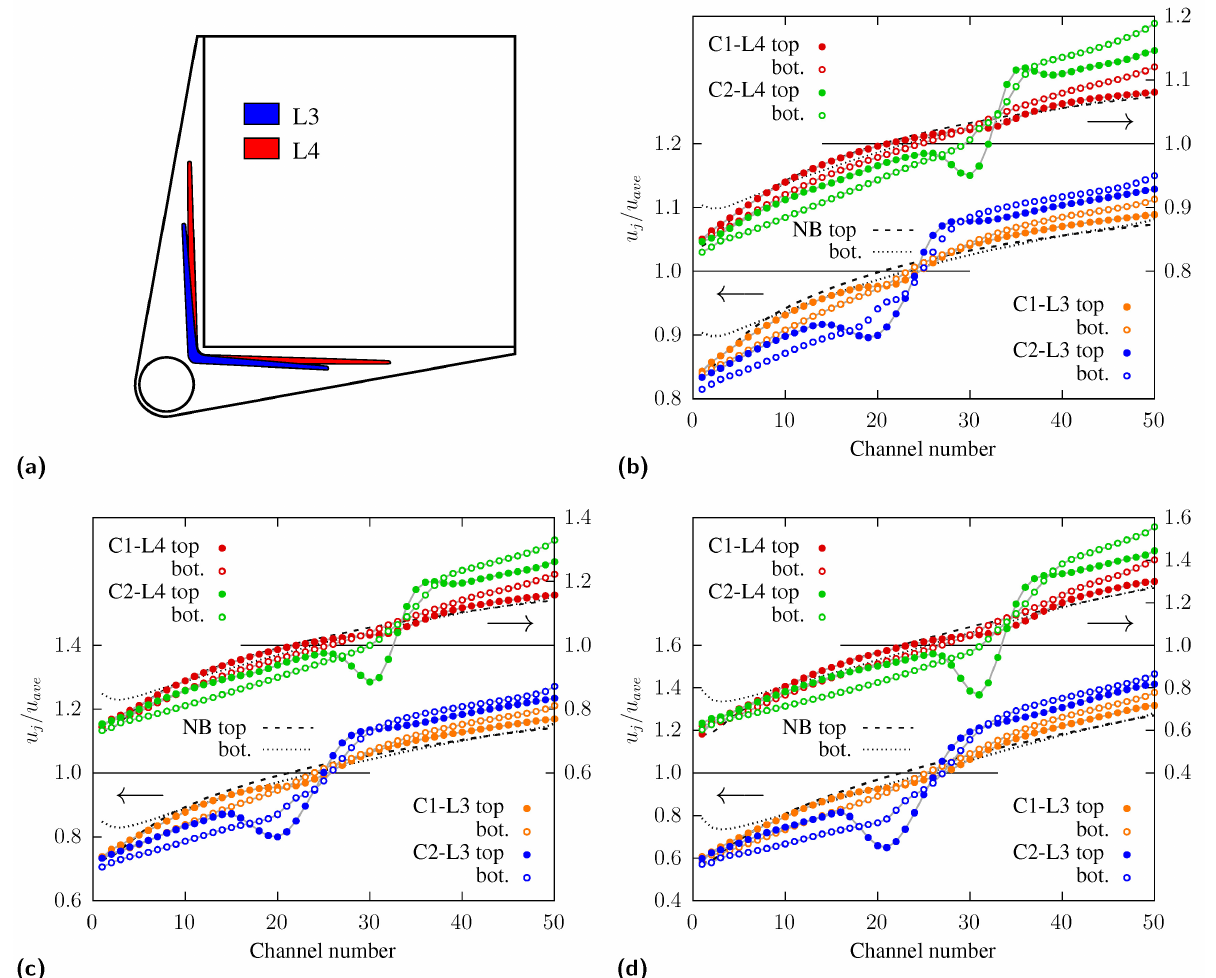
Figure 8. Header with cut baffle: ( a ) sketch of the inlet header with baffles of different lengths; normalized velocity distributions for top and bottom layers obtained with different average velocities: ( b ) u ave = 0.5 m/s, ( c ) u ave = 1.0 m/s, ( d ) u ave = 2.0